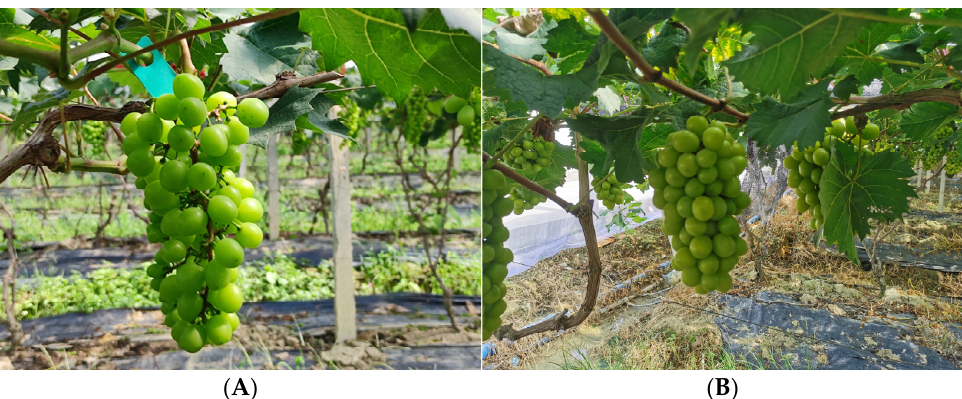
Figure 1. Grape images in front and back lighting. Front light ( A ) and back light ( B